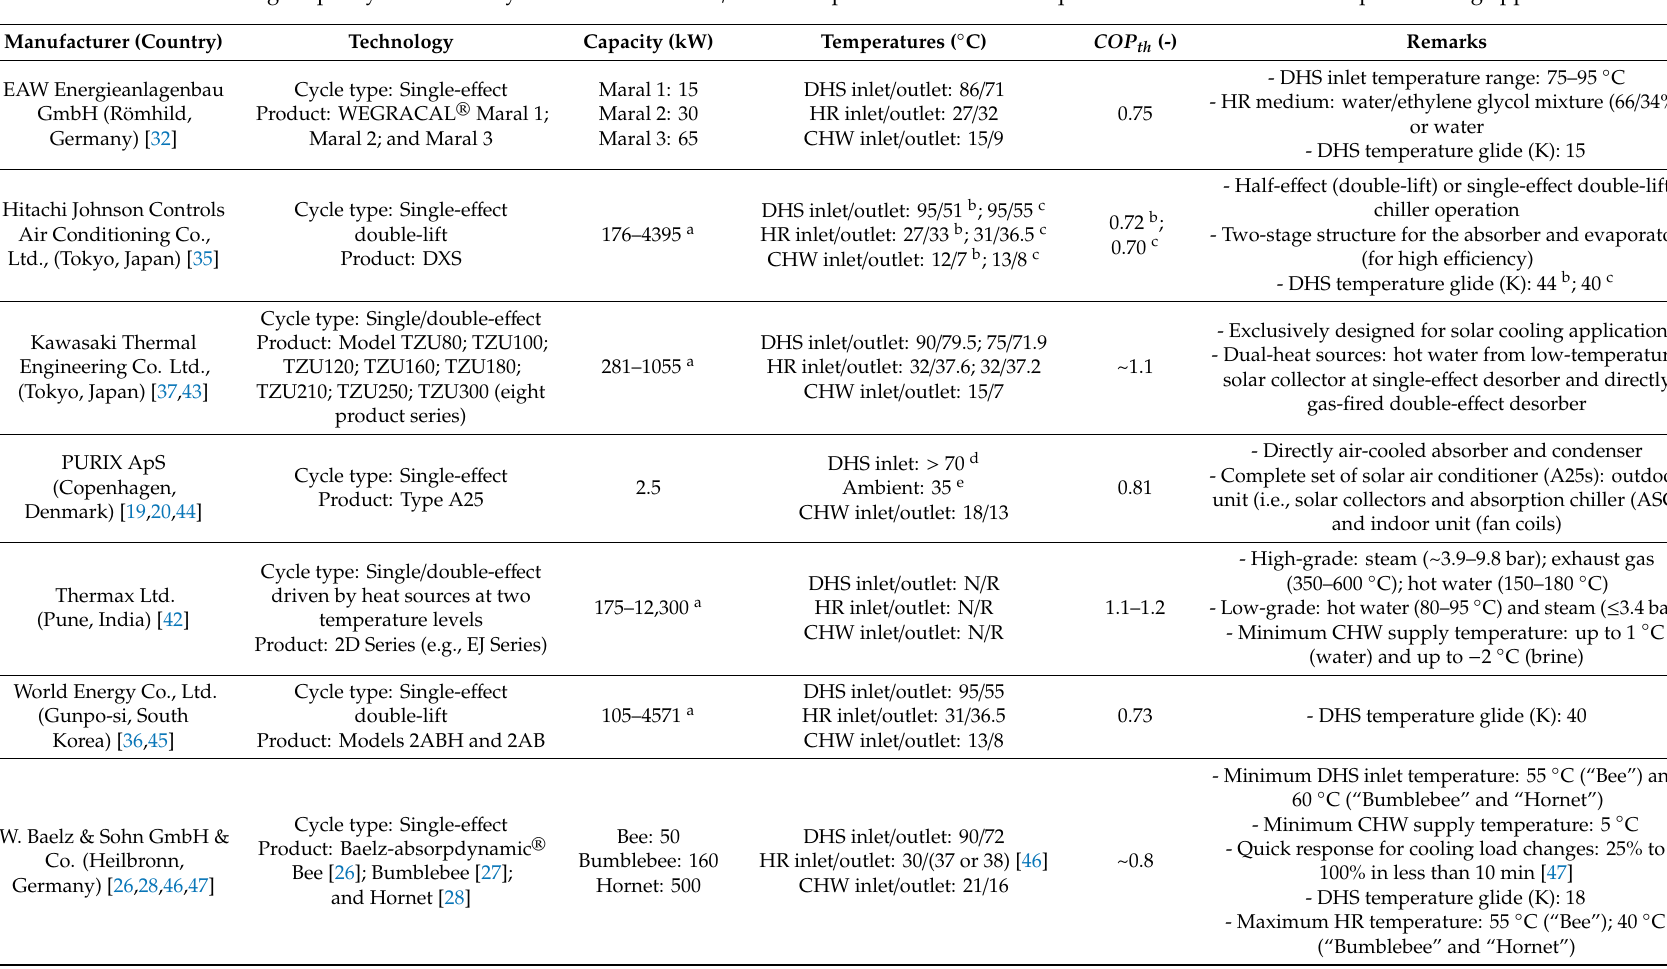
Table 1. Small-to-large capacity commercially available new water / LiBr absorption chillers with unique features suitable for solar space cooling